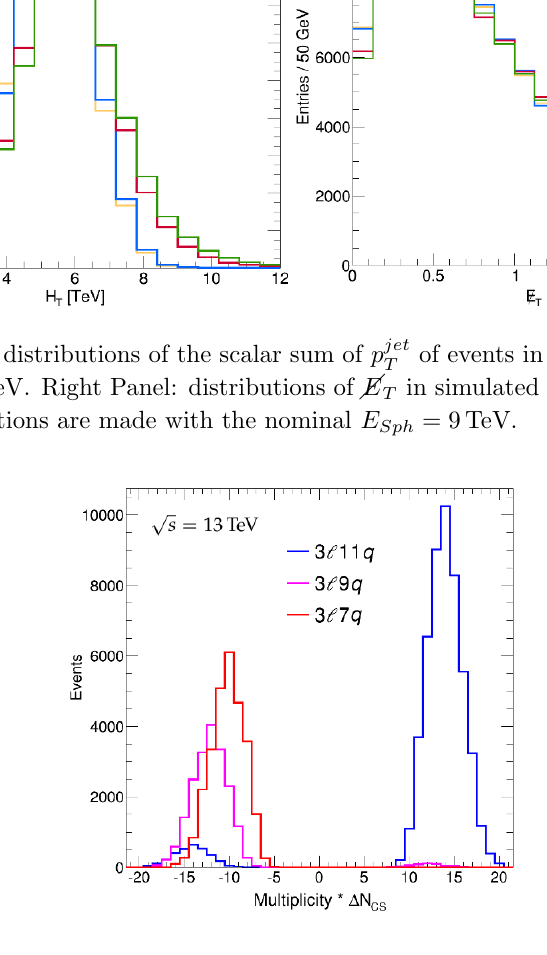
Figure 5 . The distributions of multiplicities of energetic ( p T > 20 GeV) jets and leptons within a nominal (cid:12)ducial detector acceptance of j (cid:17) j < 2 : 5, after processing with PYTHIA, including top quark and W decays, as well as jet fragmentation and hadronization. The multiplicities are plotted separately for (cid:1) N CS = (cid:6) 1 by multiplying them by (cid:1) N CS , and are shown separately for each of the possibilities for number of quark-antiquark cancellations (0, 1, and